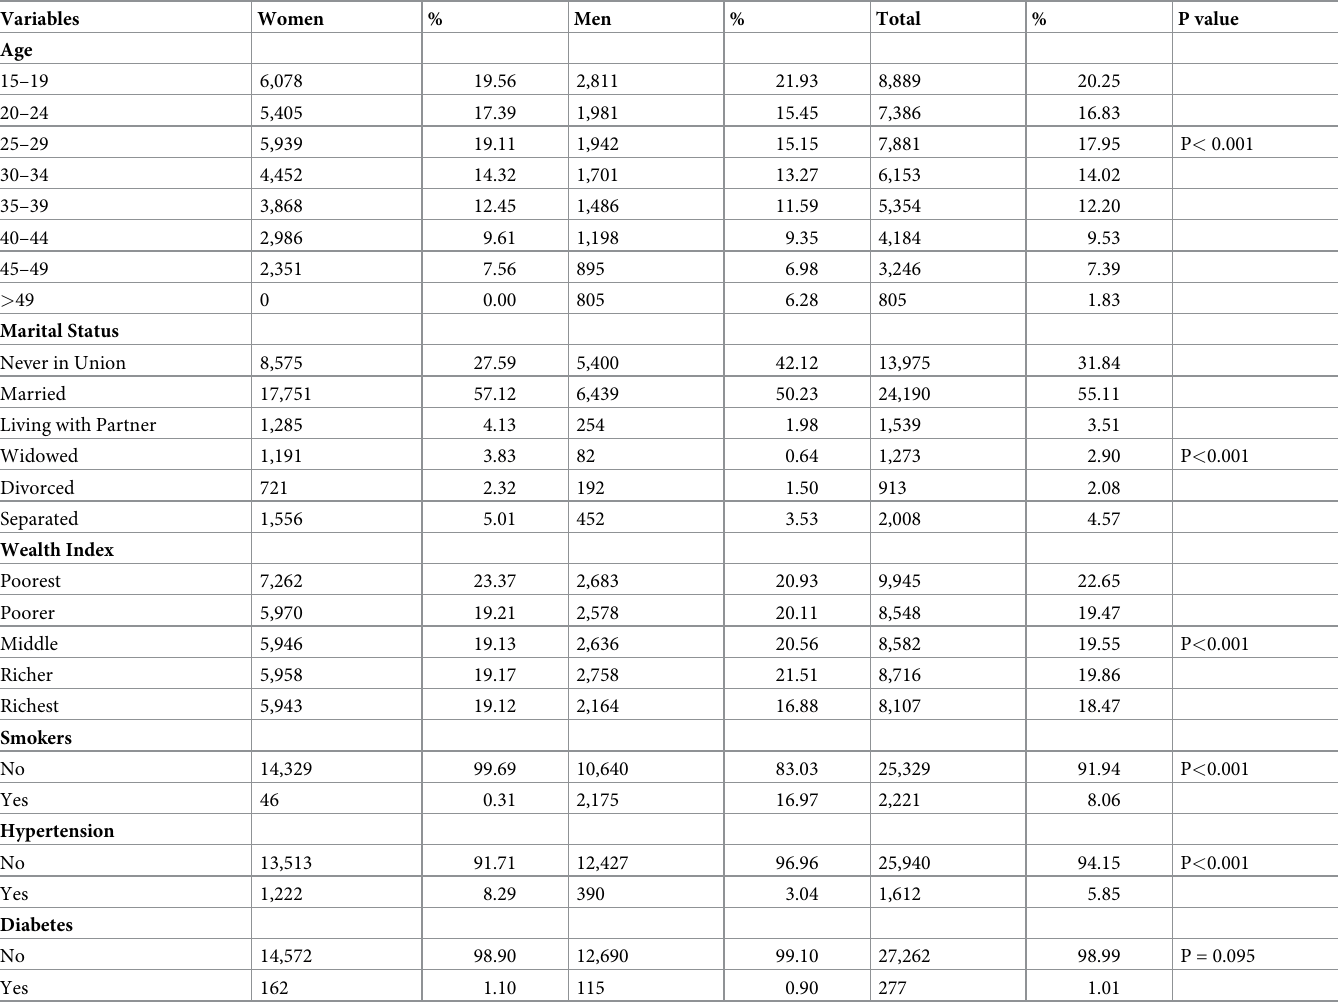
Table 1. Descriptive statistics for demographic results by